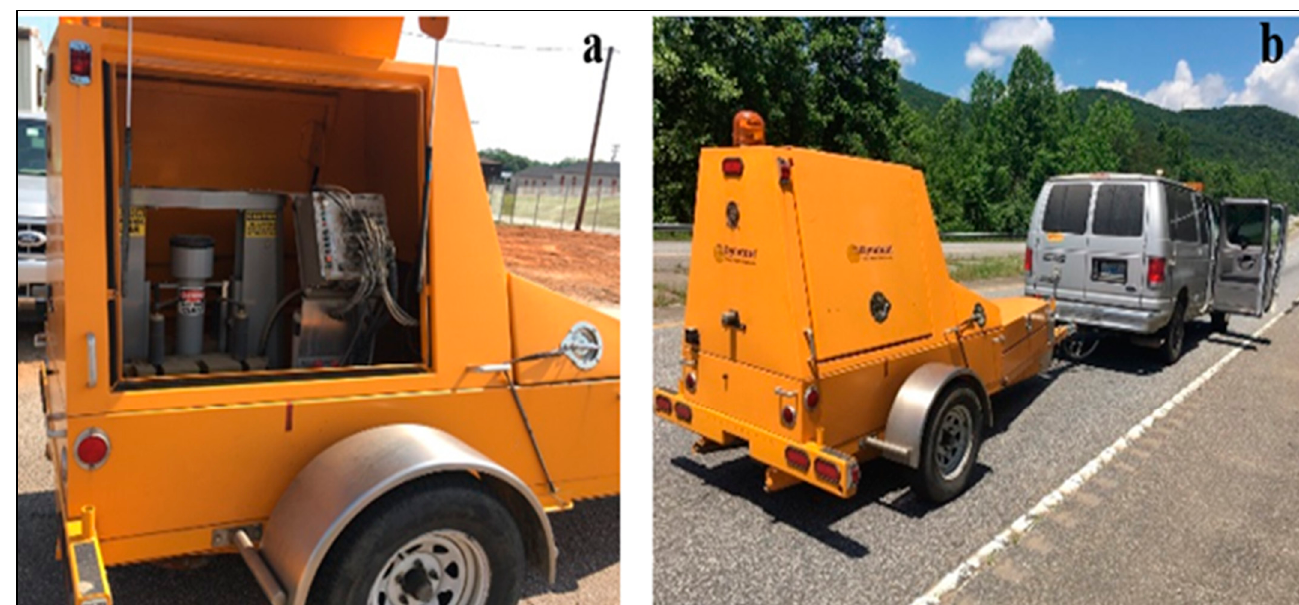
Figure 4. FWD:( a ) Loading frame, and ( b ) system .